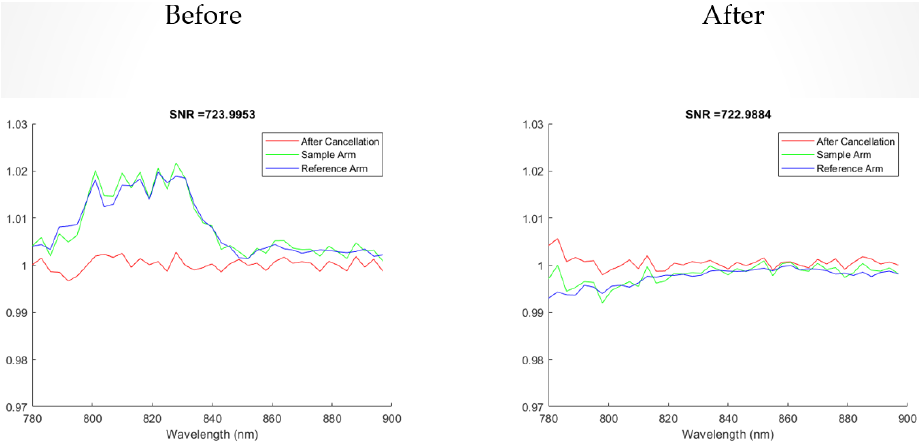
Figure 28. Repeatability comparison before and after road driving test (local roads and dirt roads).